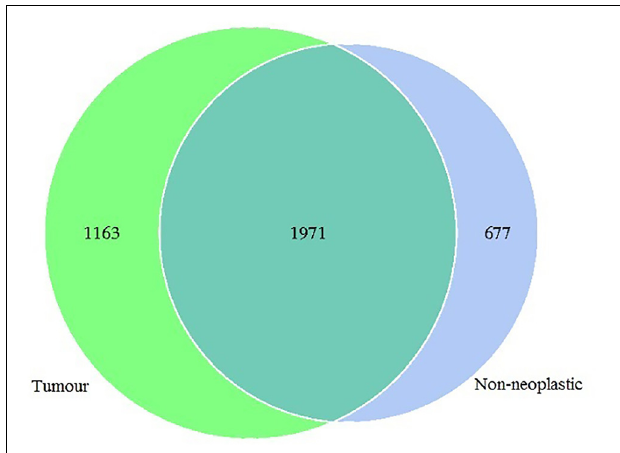
FIGURE 1 | Venn diagram showing the distribution of operational taxonomic units (OTUs) detected in the tumours and non-neoplastic